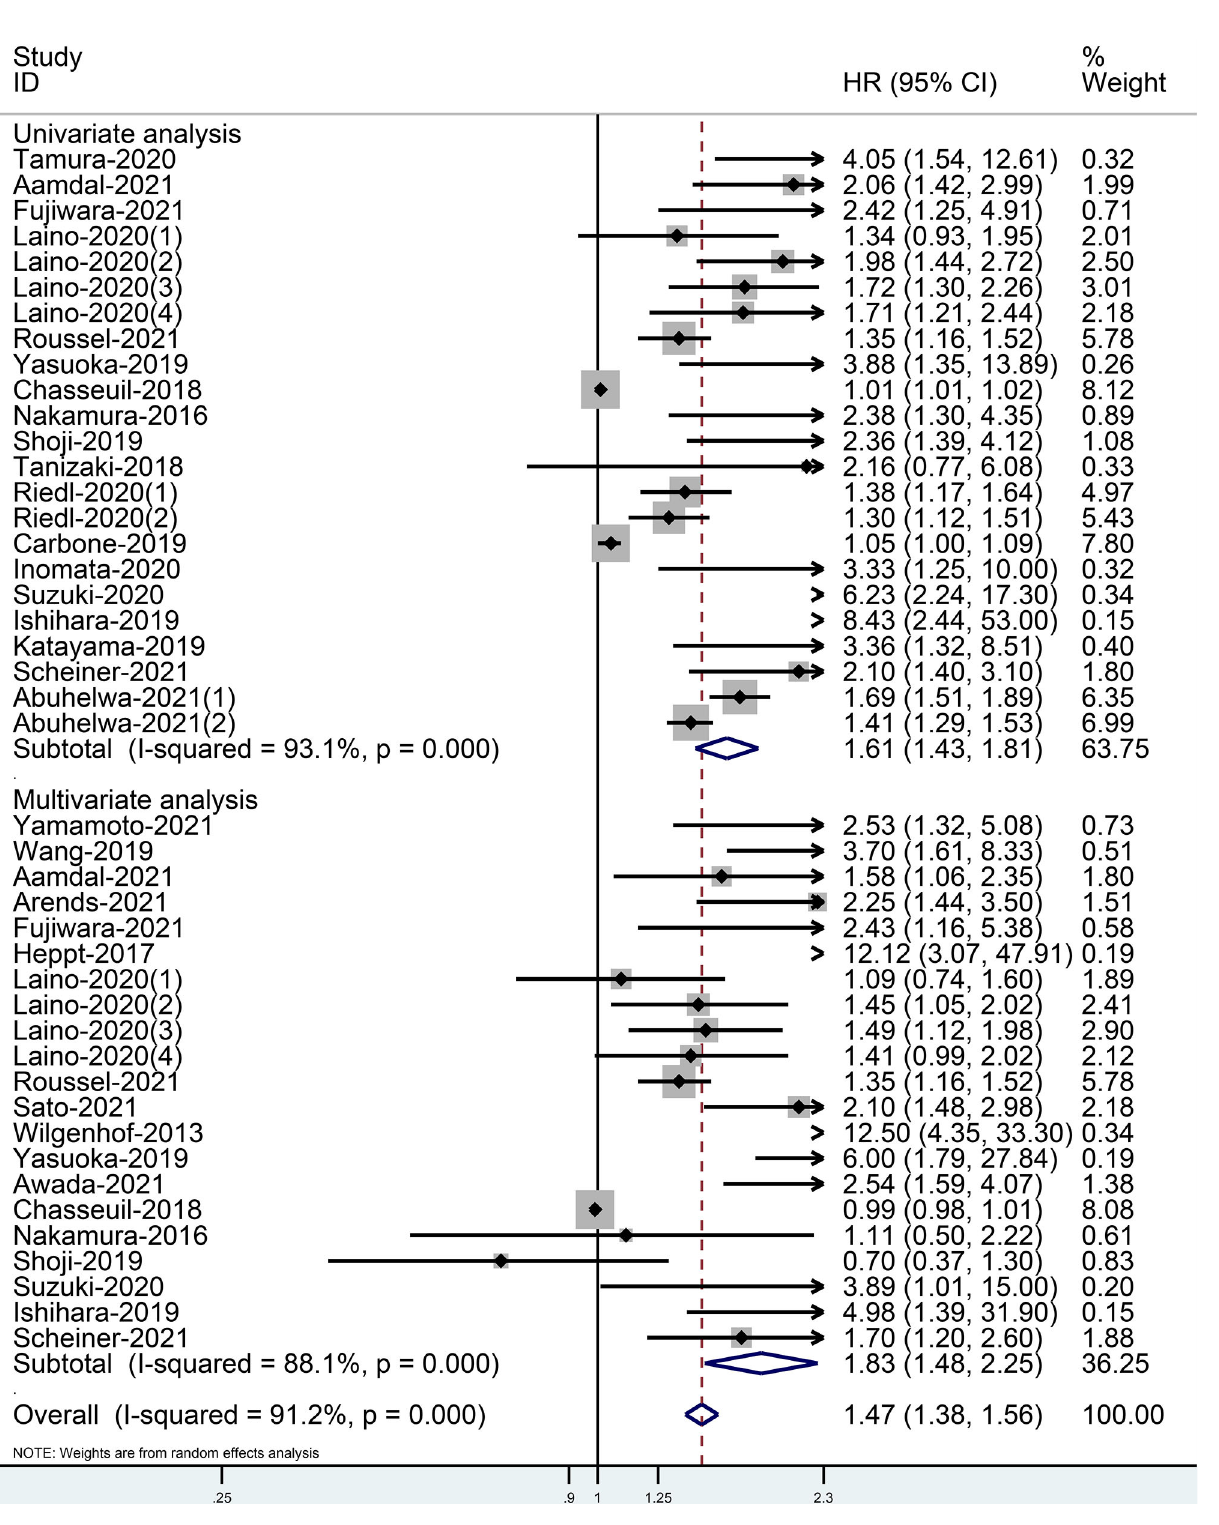
FIGURE 2 | Forest plot of pooled HR and 95% CI about the relationship of baseline CRP levels and OS categorized by univariate and multivariate analysis outcomes in cancer patients treated with ICIs (squares = HR, horizontal lines = 95% CI, rhombus = summarized HR and its 95%